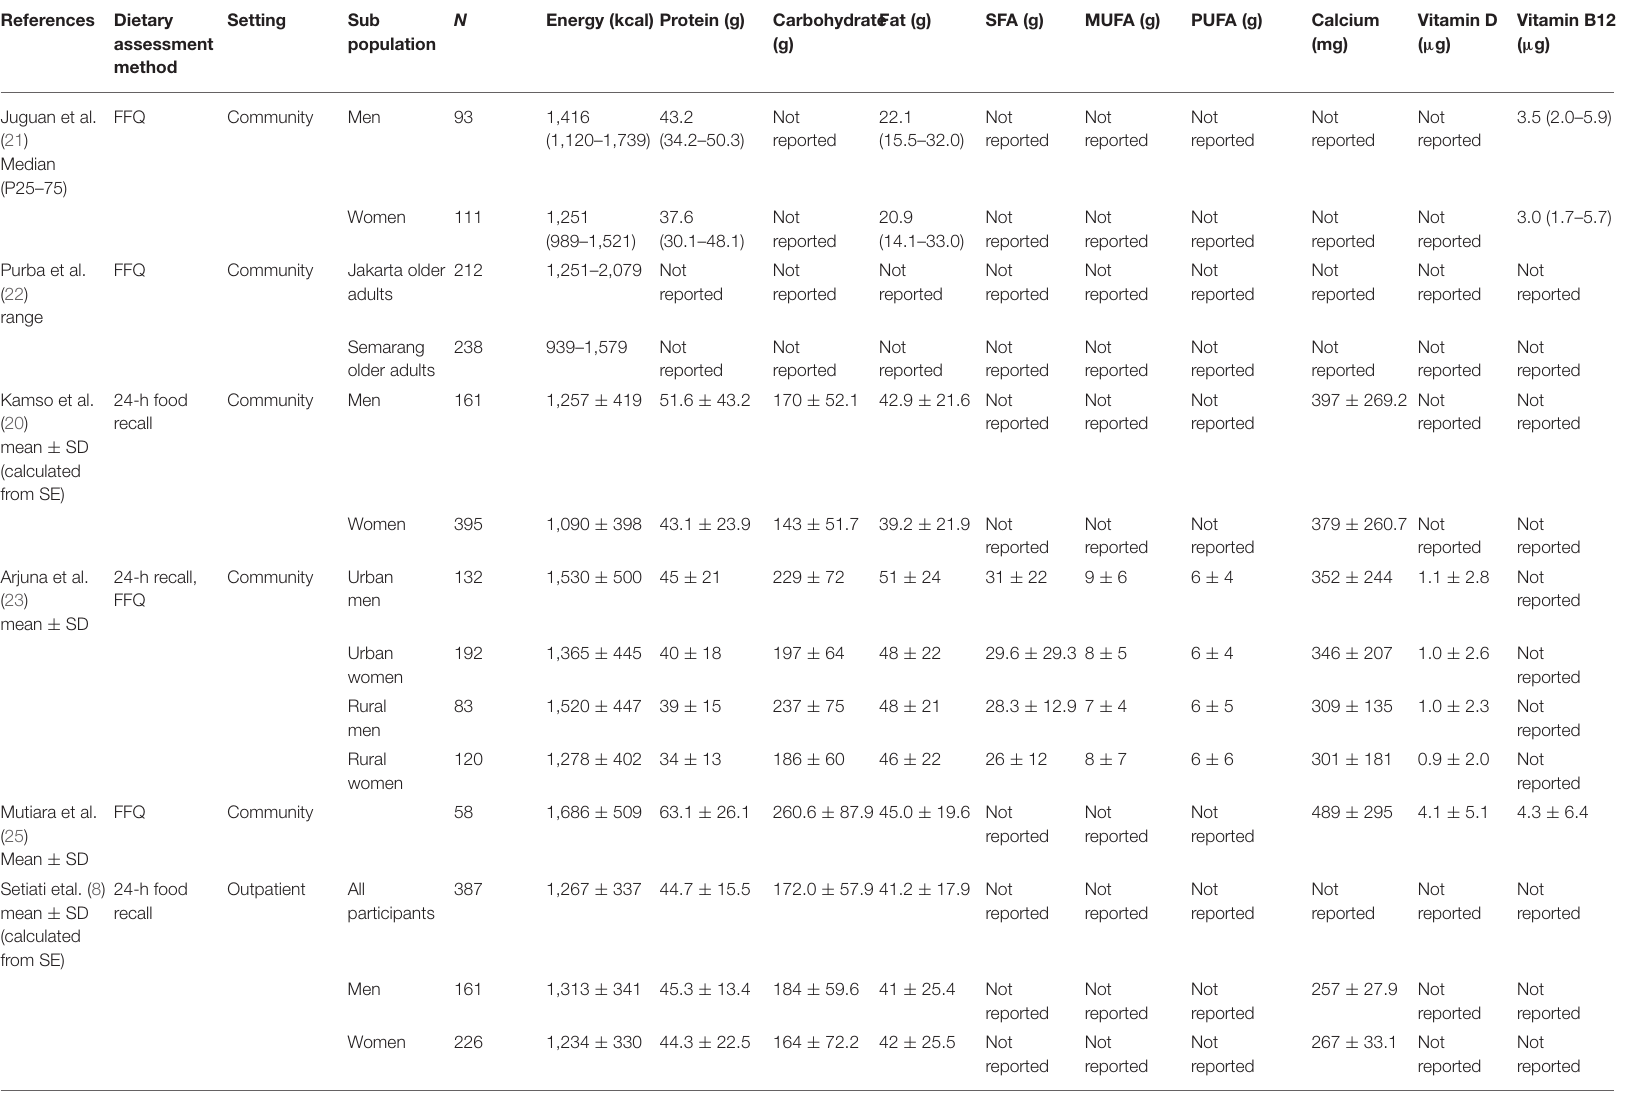
TABLE 5 | Data on the level and distribution of habitual intake of energy, macronutrients and a selection of micronutrients. References Dietary